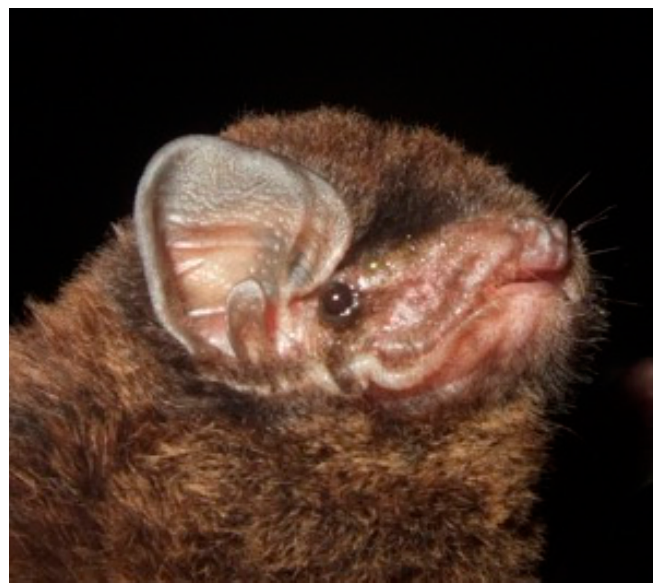
Figure 25. Miniopterus fuliginosus , adult female. Photograph by Vu Dinh Thong.